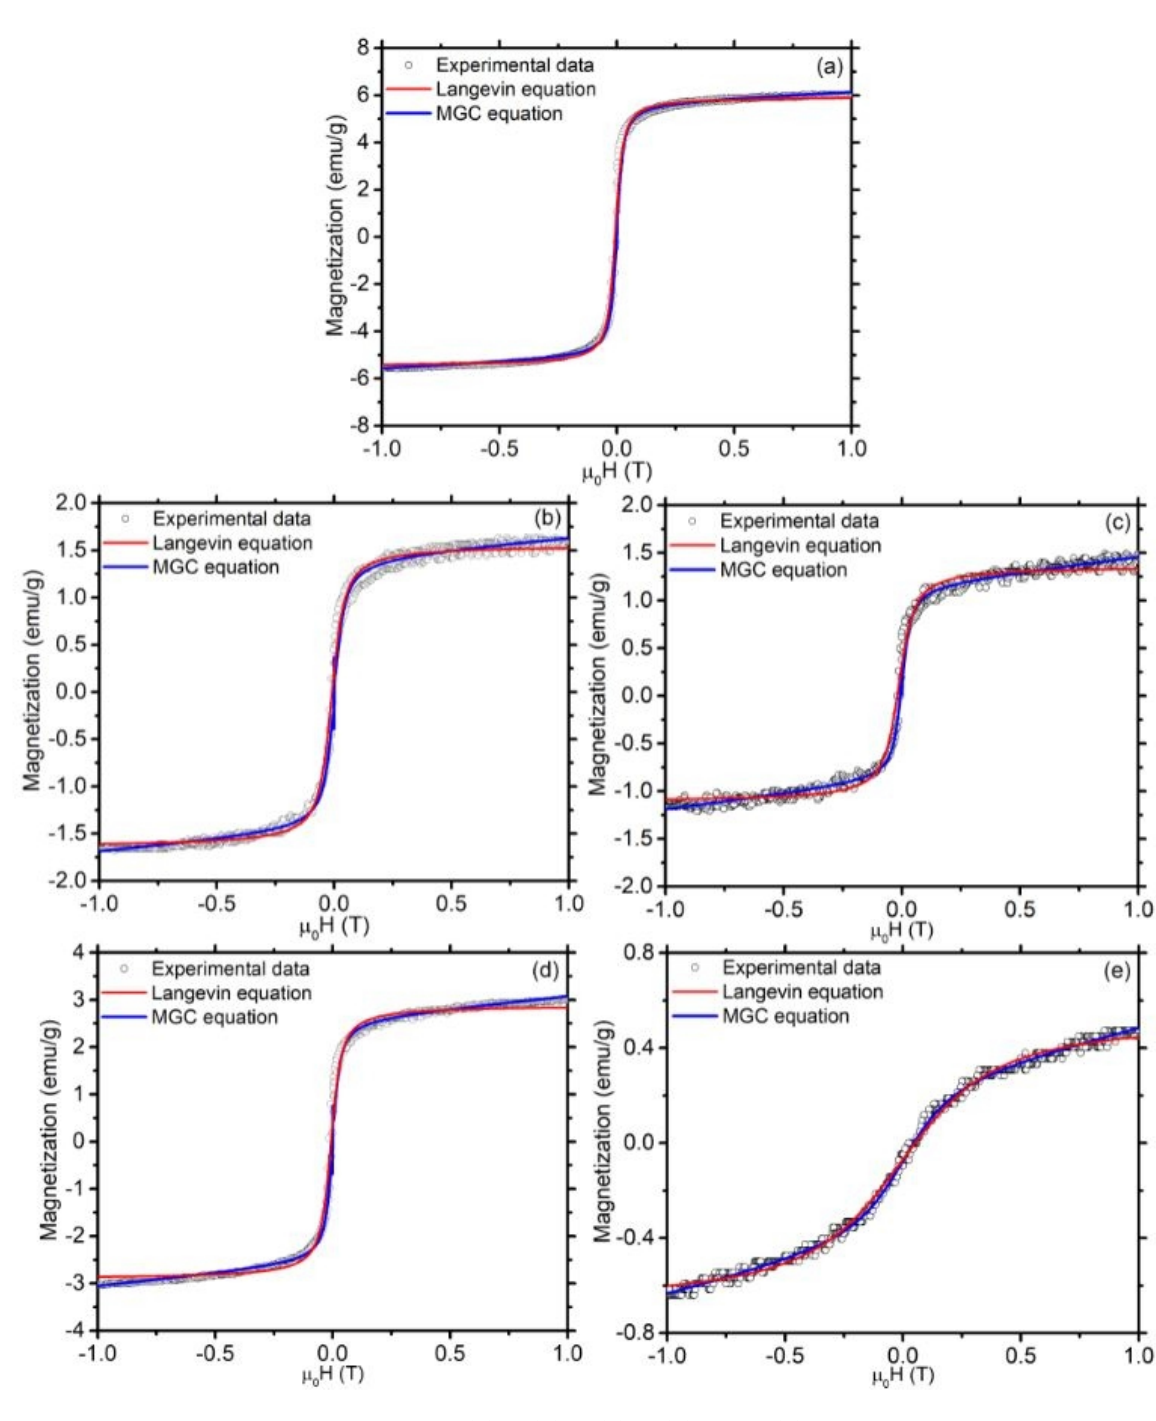
Figure 5. Magnetization curves of the samples (a) Y1, (b) Y2, (c) Y3, (d) Y4, and (e) Y5. The solid red lines represent the Langevin equation, the solid blue lines represent the MGC equation, and the black circles represent the experimental